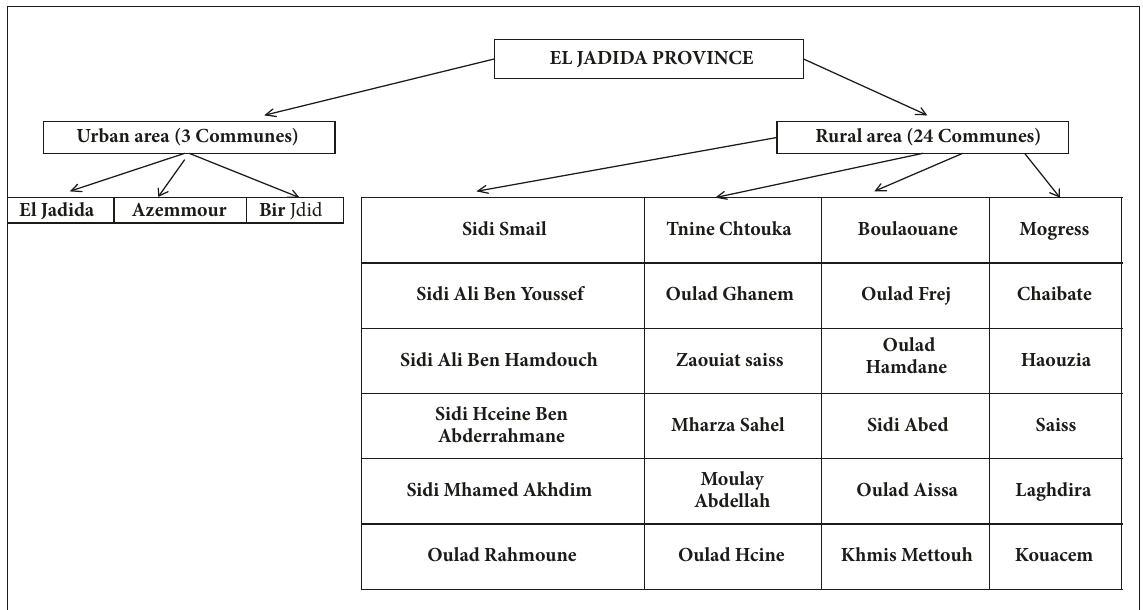
Figure 3: Municipalities concerned by household